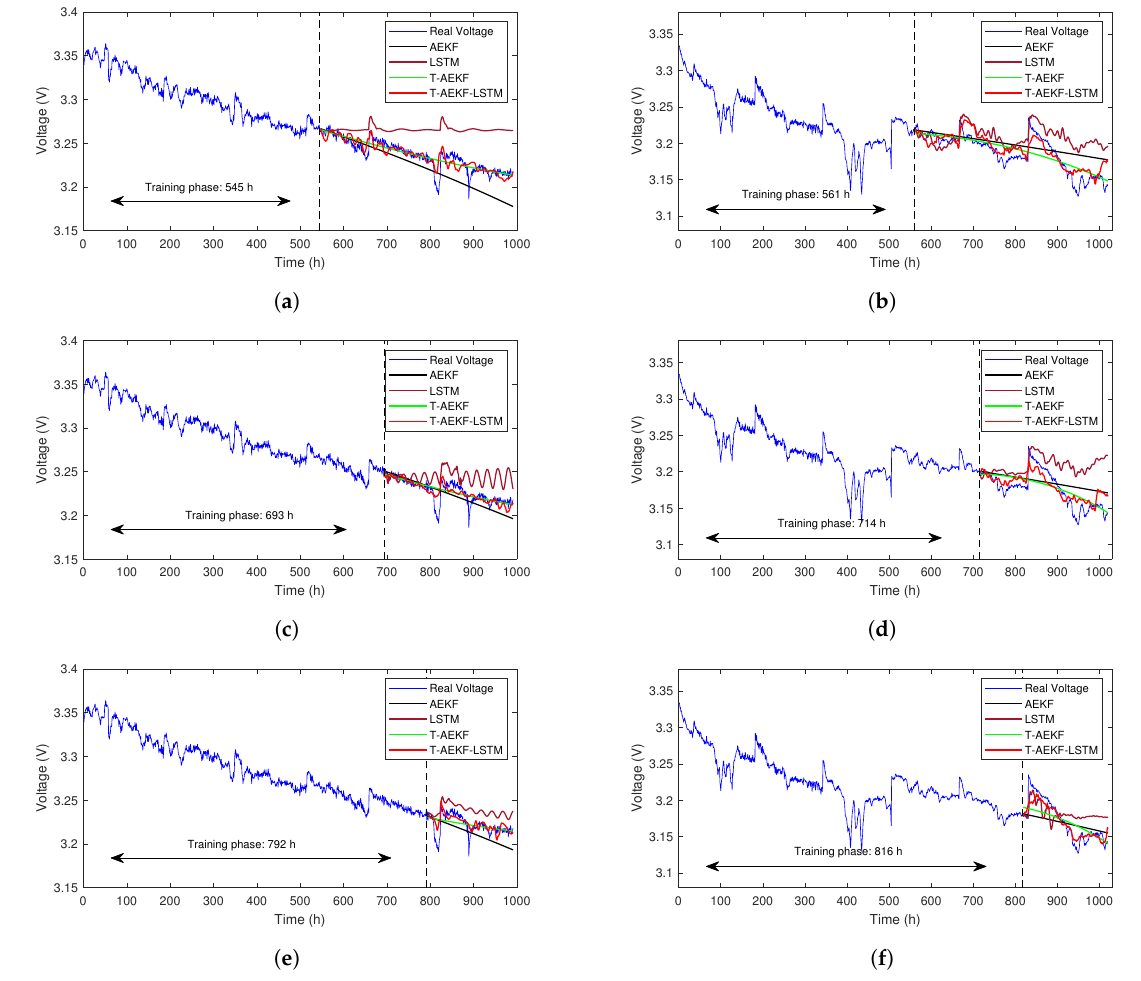
Figure 9. The prediction results of AEKF, LSTM, T-AEKF, and the proposed method (T-AEKF-LSTM). ( a ) FC1 with 55% training data; ( b ) FC2 with 55% training data; ( c ) FC1 with 70% training data; ( d ) FC2 with 70% training data; ( e ) FC1 with 80% training data; ( f ) FC2 with 80% training data.